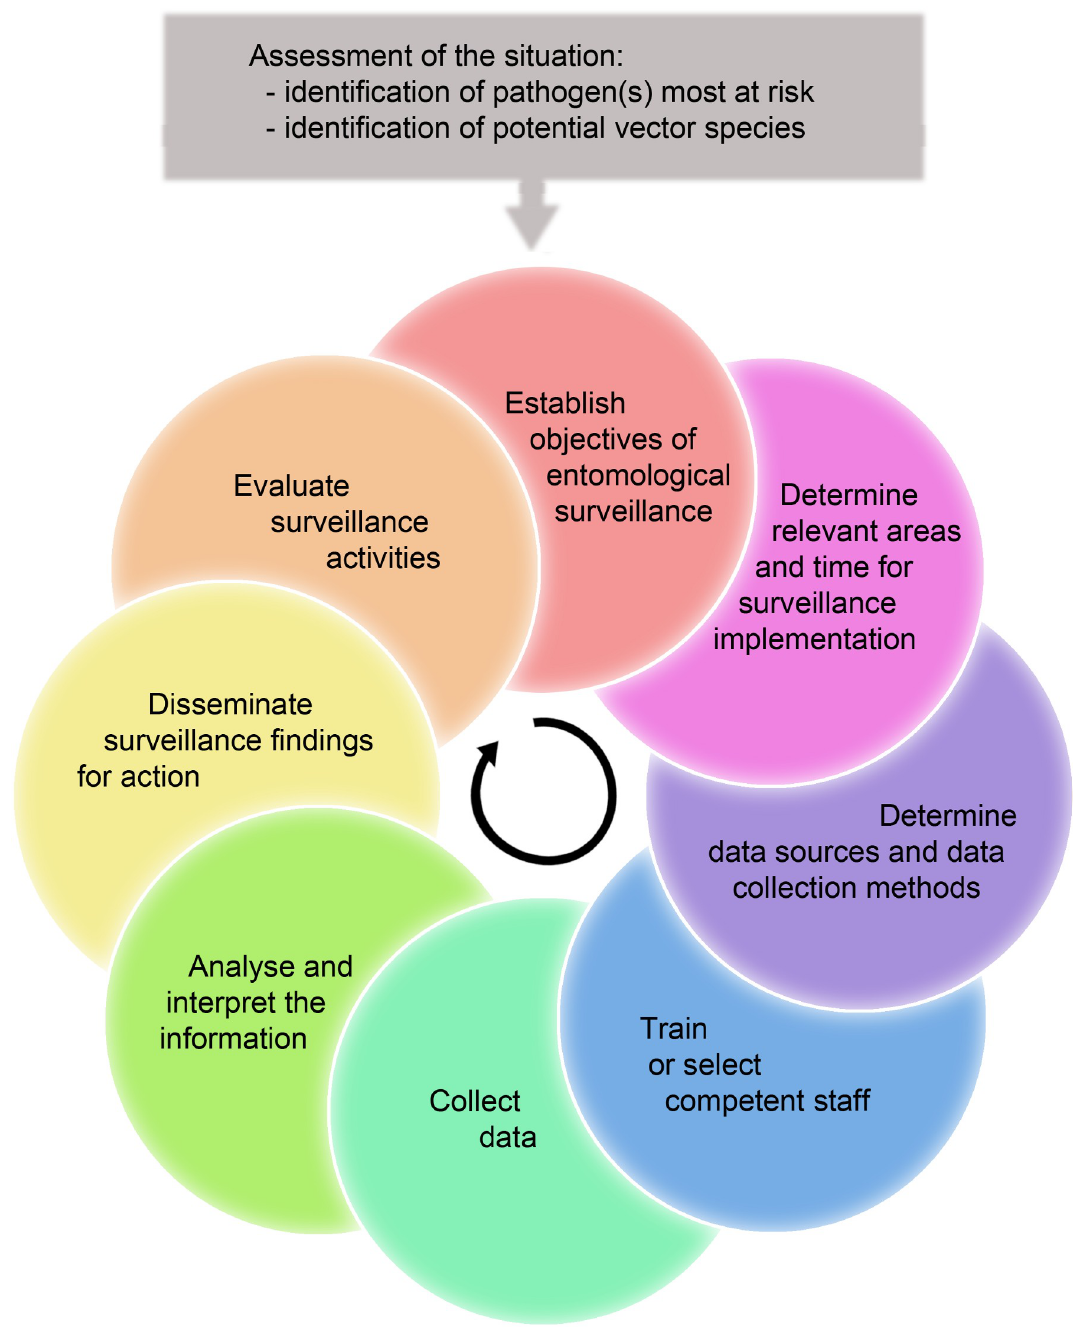
Fig 2. Process for implementing and updating entomological surveillance